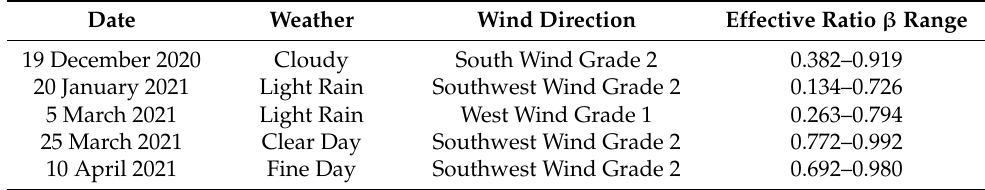
Figure 6. Data effective ratio. Table 2. Historical weather